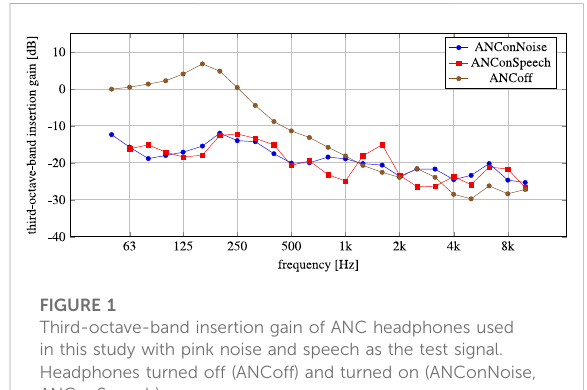
FIGURE 1 Third-octave-band insertion gain of ANC headphones used in this study with pink noise and speech as the test signal. Headphones turned off (ANCoff) and turned on (ANConNoise,